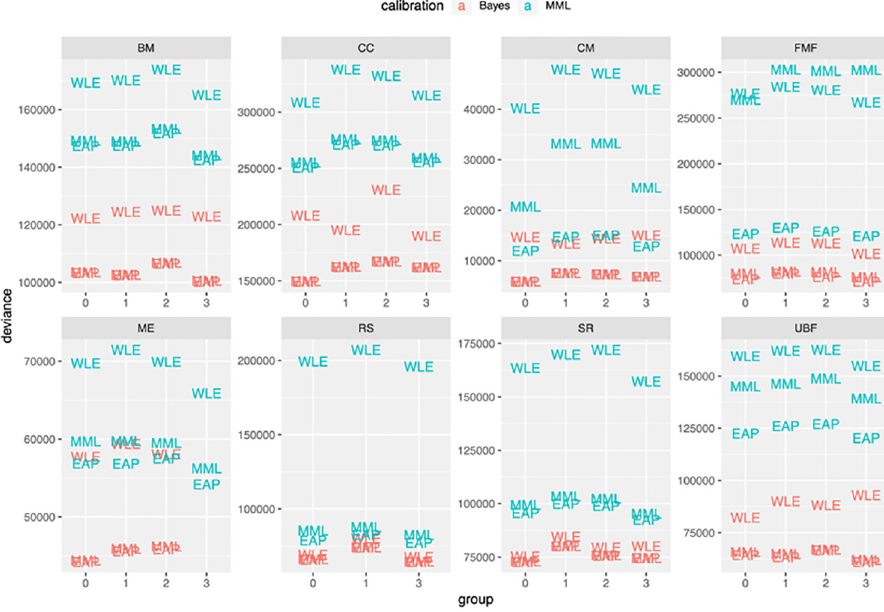
Fig 3. Point-estimated out-of-sample comparison of calibration and scoring choices on claimant responses for 8 domains of the WD-FAB (lower is better). The point-estimated deviance measure is computed by taking the variance parameters in Eq 7 to zero. This measure is scaled in-line with the AIC so lower values are better.